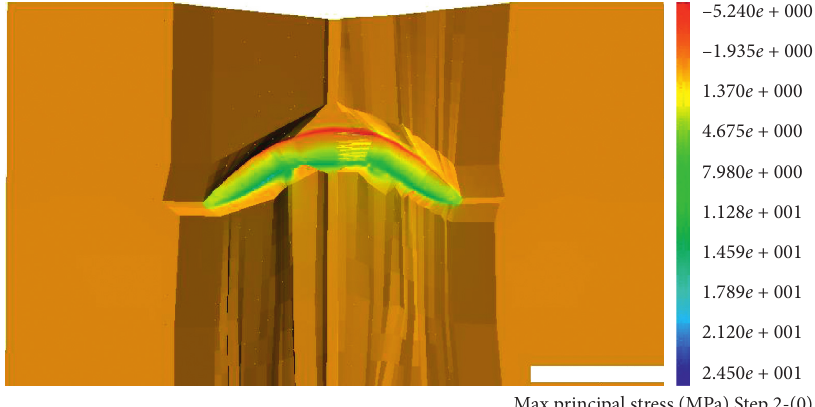
Figure 11: Maximum principal stress of foundation under working condition 4 (unit: